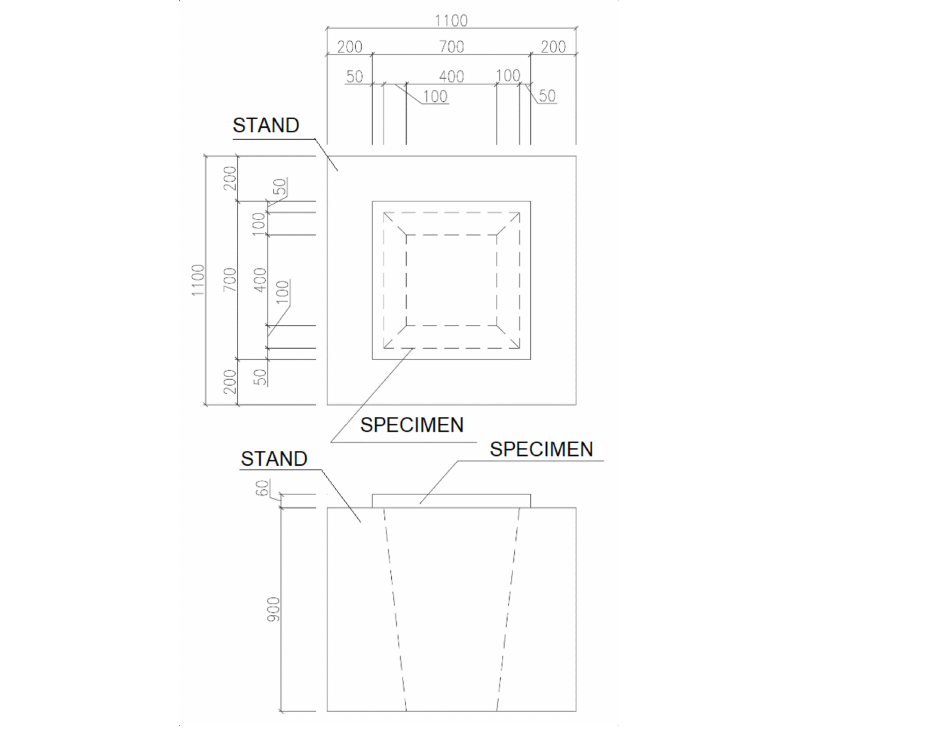
Figure 6. Drawing of the stand and the